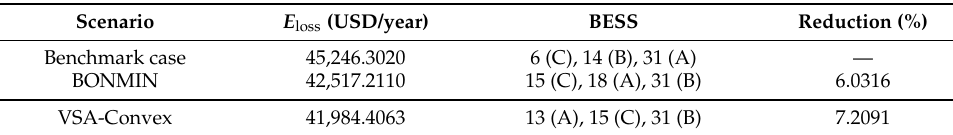
Table 4. BESS location reallocation when E loss is